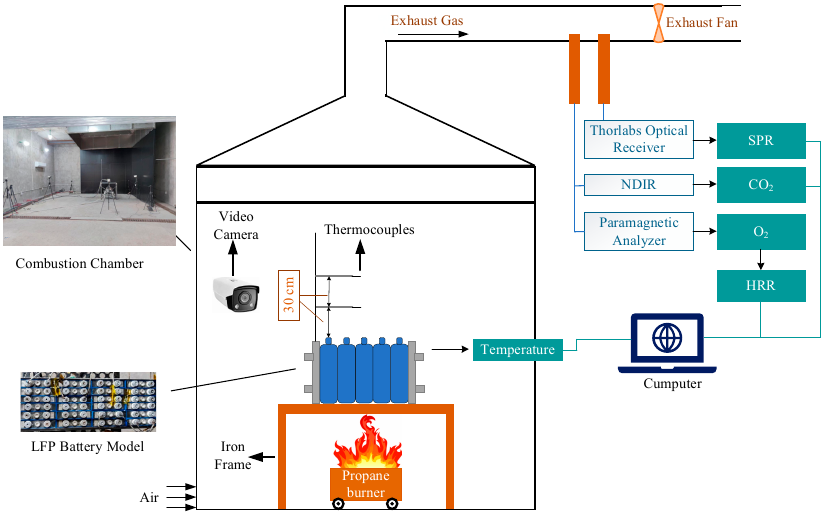
Figure 2. Schematic illustration of experimental apparatus.